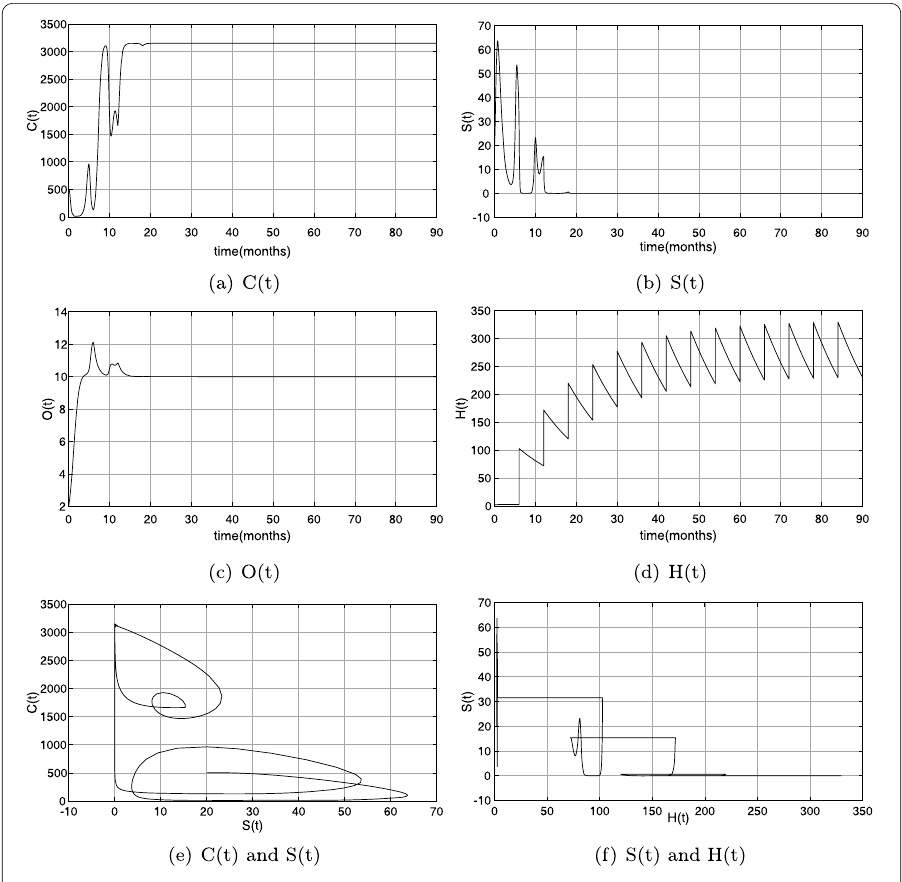
Figure 1 Strategy 1: C (0) = 500, S (0) = 20, O (0) = 2, H (0) = 2, h = 100, T = 6 ( a ) the dynamic of C ( t ), ( b ) the dynamic of S ( t ), ( c ) the dynamic of O ( t ), ( d ) the dynamic of H ( t ), ( e ) the dynamic of C ( t ) and S ( t ), ( f ) the dynamic of S ( t ) and H ( t